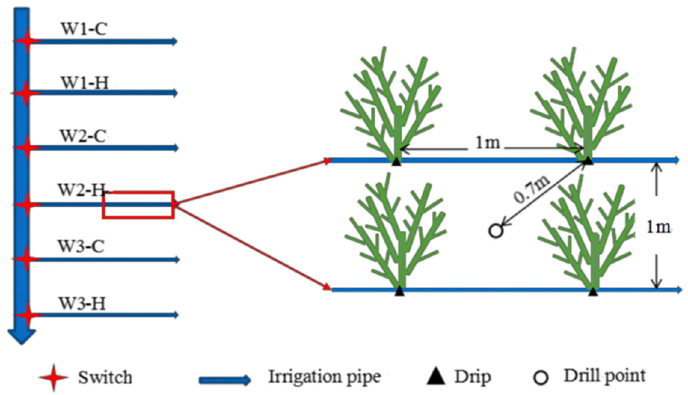
Figure 2. Schematic diagram of field experiment design.